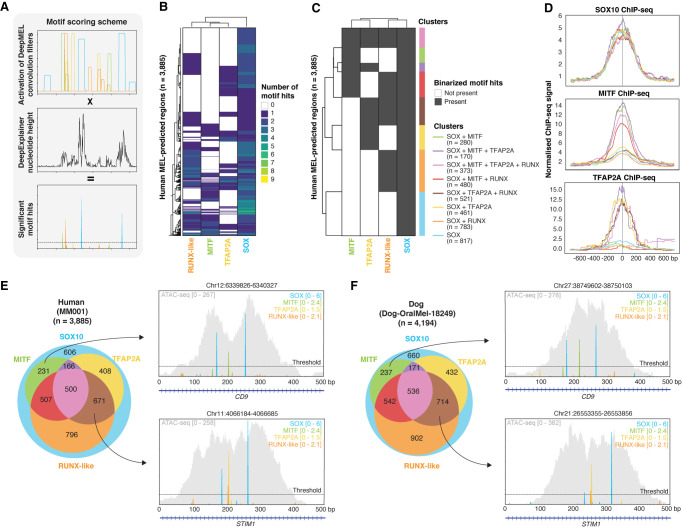
Core Regulatory Complex of MEL melanoma enhancers. (A) Schematic overview of motif scoring method in which extended convolutional filter hits from DeepMEL are multiplied by DeepExplainer profiles to yield significant motif hits. (B,C) Heatmap (B) and binarized heatmap (C) of the number of significant SOX, TFAP2A, MITF, and RUNX-like motif hits on the 3885 MEL-predicted regions in the human cell line MM001. (D) Aggregation plot of normalized ChIP-seq signal of SOX10, MITF, and TFAP2A on the human enhancer clusters. (E,F) Venn diagram of regions clusters on the 3885 MEL-predicted regions in human (in MM001) (E) and the 4194 MEL-predicted regions in dog (in Dog-OralMel-18249) (F). Example MEL-predicted enhancers in human and dog are shown for two of the region clusters. The ATAC-seq signal of the regions is shown in gray.